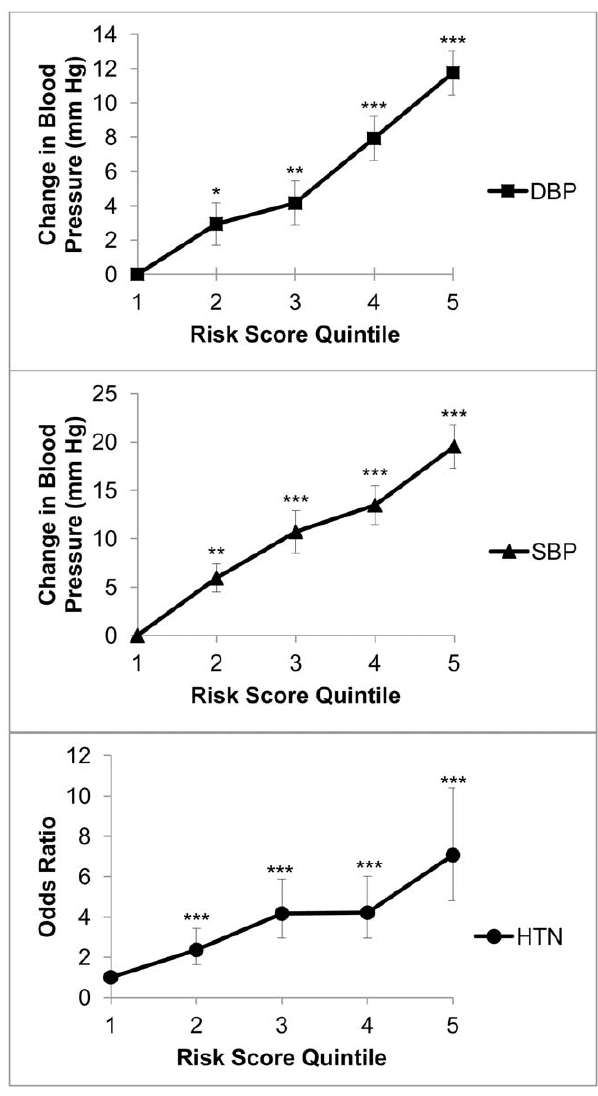
Figure 2. Line graphs representing the ADRA1 pathway genetic risk model for DBP, SBP, and hypertension (HTN). The risk score was divided into quintiles, with the reference category being the lowest risk score quintile. * P , 0.05. ** P , 0.005. ***P , 0.0001.